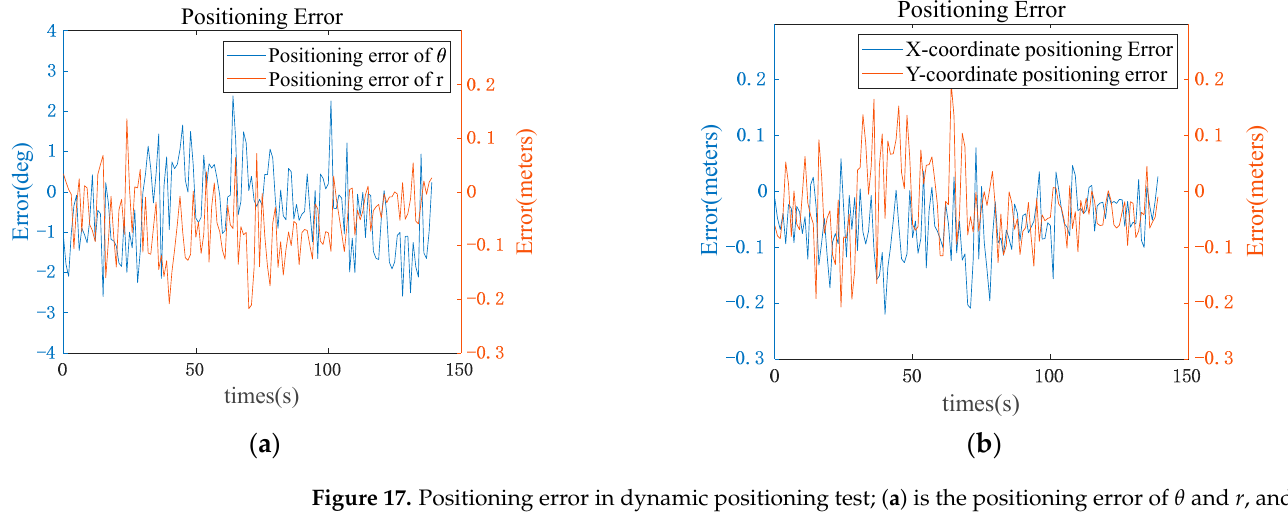
Figure 17. Positioning error in dynamic positioning test; ( a ) is the positioning error of θ and r , and ( b ) is the positioning error of the x and y coordinates.